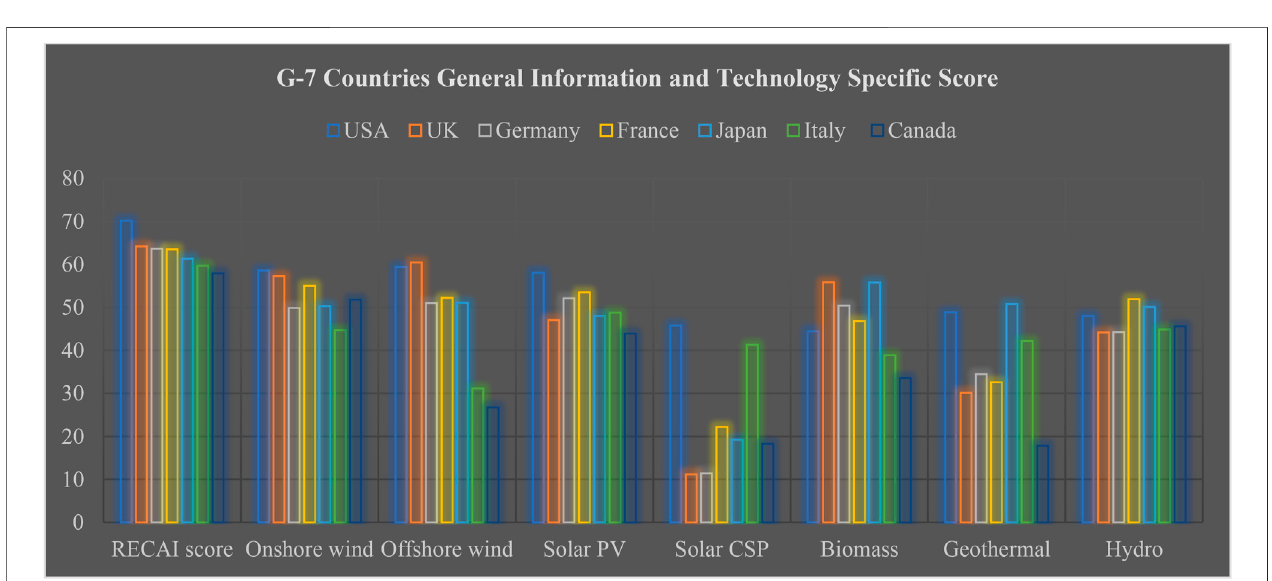
FIGURE 4 | Comparison of technology-speci fi c score of G7 countries. Data source: author elaboration.